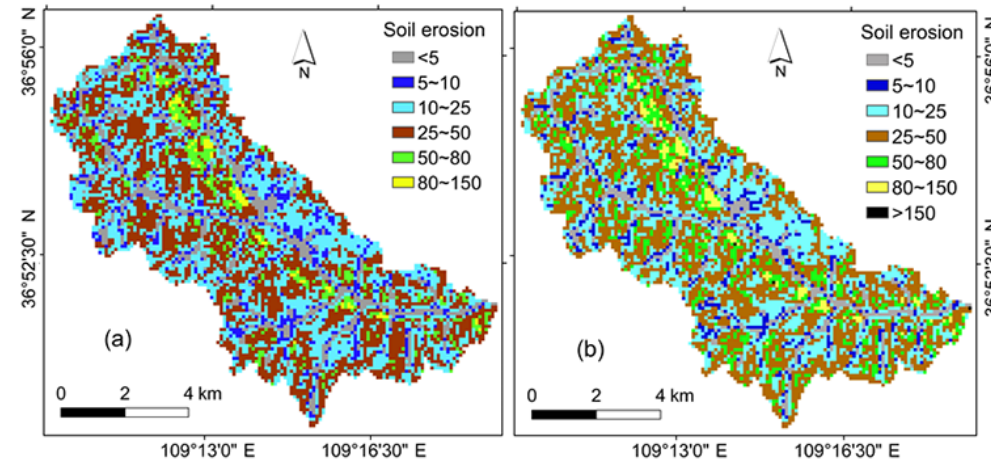
Figure 7. Spatial distribution of soil erosion gradations (Mgha − 1 ) of the Majiagou River watershed: (a) 1995; (b) 2010. Table 2. Classification and gradation of soil erosion; percentage in the Majiagou River watershed in 1995 and 2010. Erosion Erosion